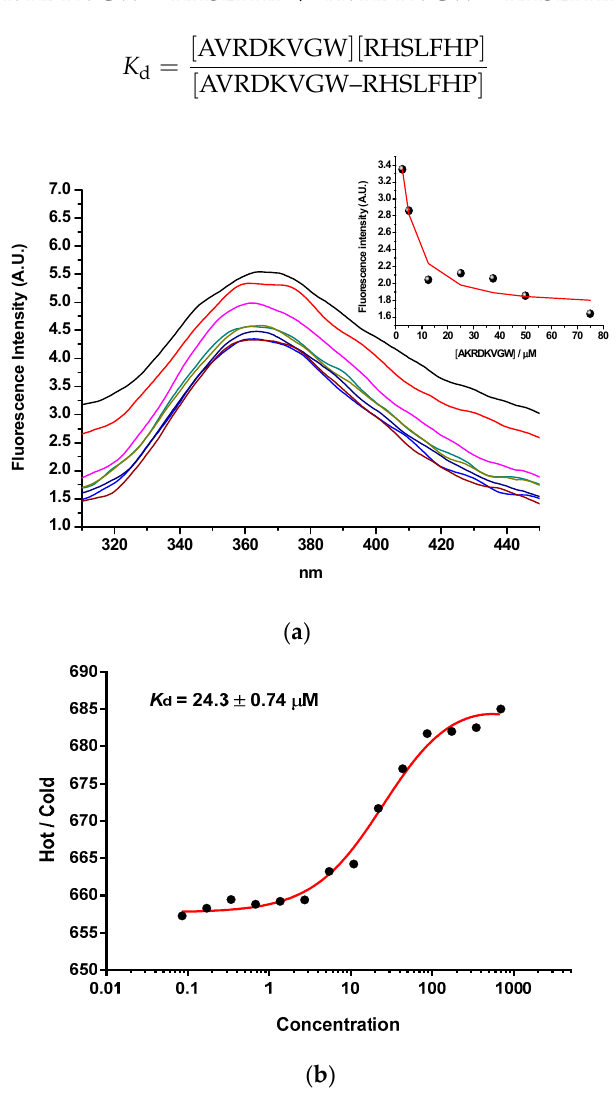
Figure 3. ( a ) Tryptophan fluorescence spectroscopy of the hPSA epitope RHSLFHP and its antisense ligand AVRDKVGW. Insert: Fitting curve at 360 nm. ( b ) Microscale thermophoresis of the hPSA epitope RHSLFHP and its antisense ligand Biotin-AVRDKVG.